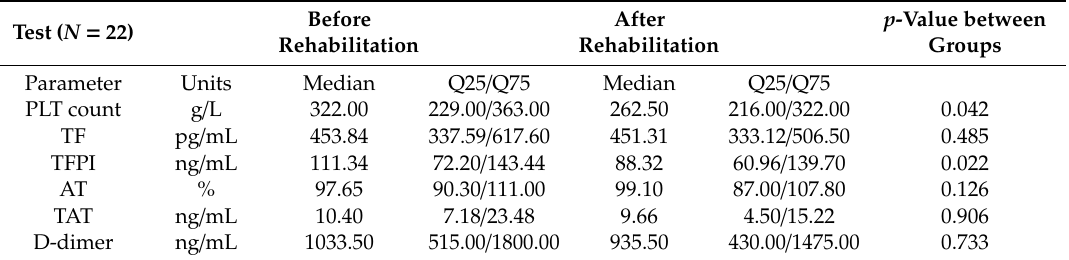
Table 5. Parameters of hemostasis before and after a four-week rehabilitation program in patients from group II (three months to six months after